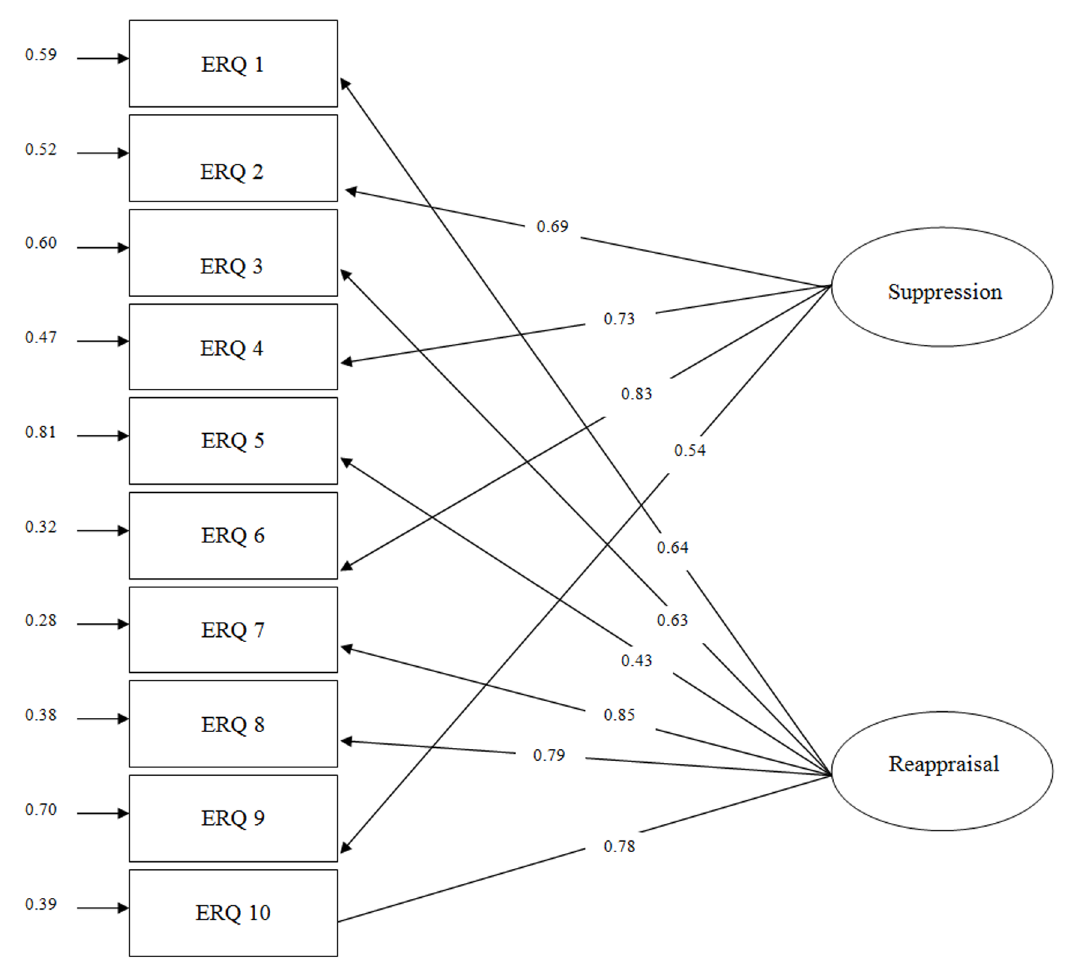
Figure 1. Confirmatory factor analysis of the Emotion Regulation